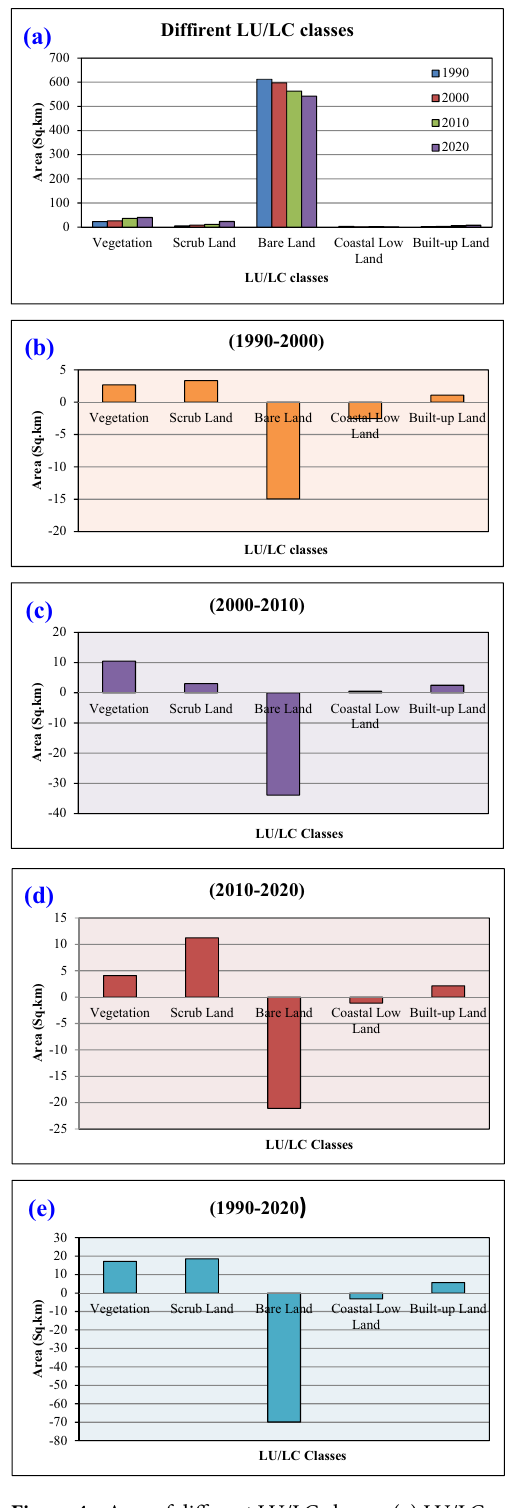
Figure 4. Area of different LU/LC classes; ( a ) LU/LC area for different years; ( b ) area change during 1990–2000; ( c ) area change during 2000–2010; ( d ) area change during 2010–2020; ( e ) area change during